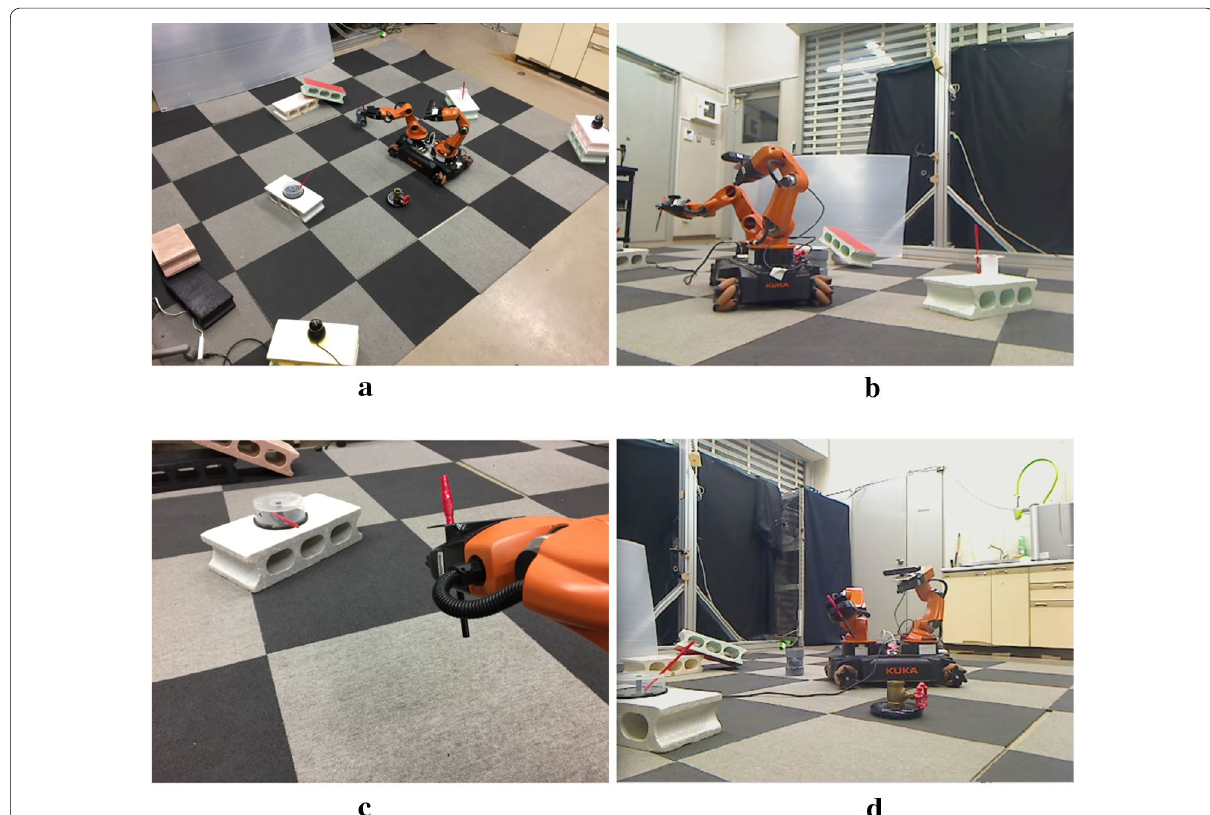
Fig. 15 Snapshot of experiment without support. a Working robot under operation, b view from static camera one, c view from working robot, d view from static camera